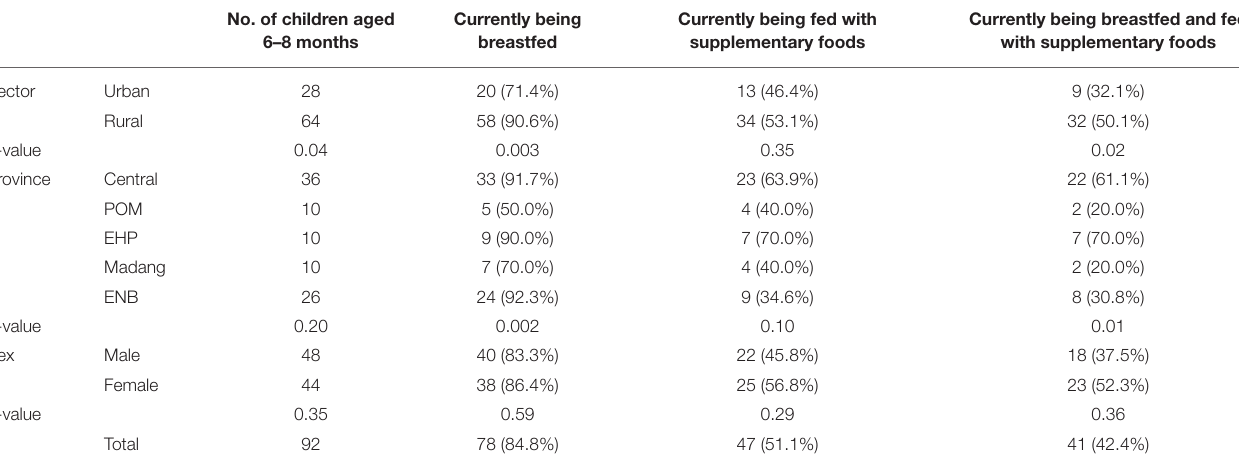
TABLE 2 | Breastfeeding and supplementary semi-solid and solid foods among infants aged 6–8 months, PNGIMR’s CHESS, 2020.